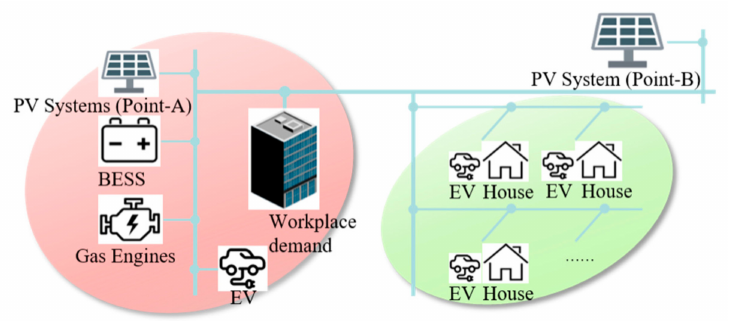
Figure 2. Power system schematic